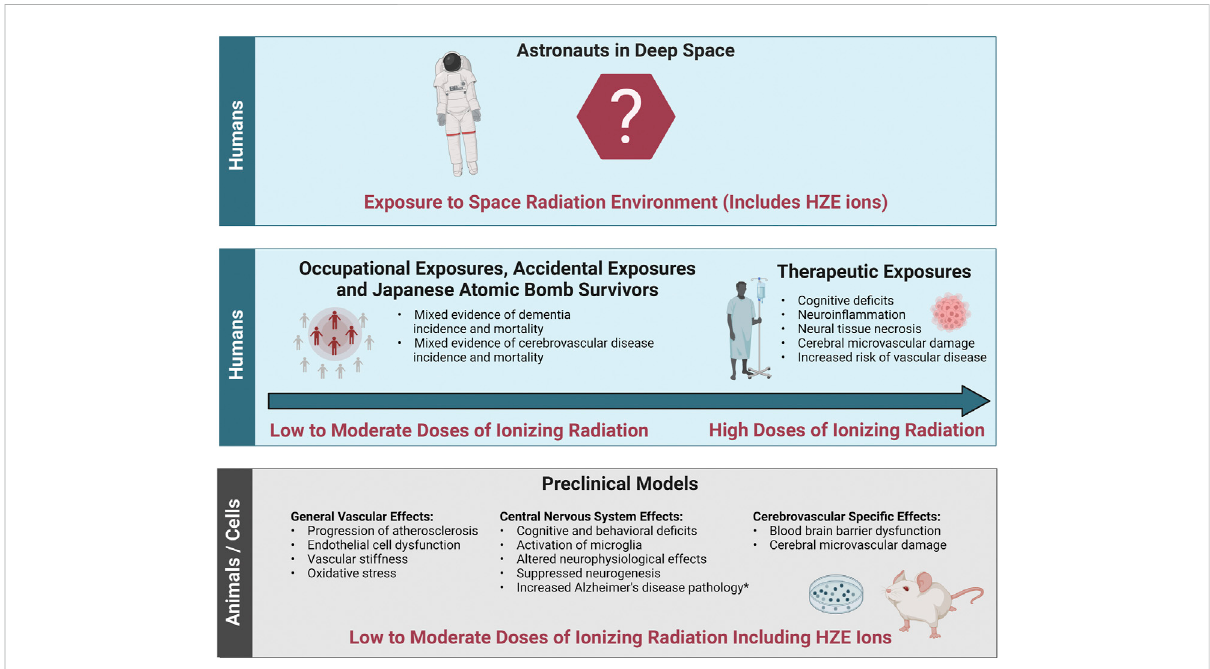
FIGURE 3 Evidence base of the effects of ionizing radiation relevant to cerebrovascular disease and dementia. The evidence base regarding the effects of ionizing radiation on cerebrovascular disease and dementia relevant to the space radiation environment consists of data from both humans and preclinical animal and cell models. Bottom panel: General vascular effects, central nervous system effects and cerebrovascular speci fi c effects in preclinicalanimalandcellmodelsirradiatedwithlow( < 0.1 Gy)tomoderate(0.1Gy – 0.5 Gy)dosesofprotonsorhigh(H)atomicnumber(Z)and energy (E) (HZE) ions. Middle panel left: Effects in cohorts of individuals exposed to low-to-moderate doses of terrestrial ionizing radiation including accidentally exposed individuals, Japanese Atomic Bomb Survivors, and occupationally exposed workers. Middle panel right: Effects in radiotherapy patients irradiated with high doses (ones to tens Gy and above). Top Panel: Translation of this evidence base into astronauts exposed to the space radiation environment is challenging due to the lack of evidence at the dose-rates and qualities related to long-term space fl ight such as deep